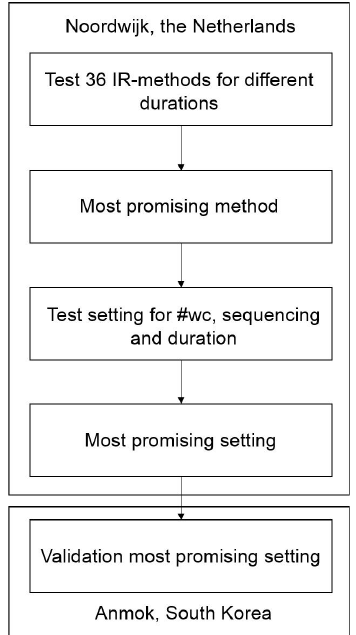
Figure 2. Flowchart of the research outline of this study, #wc is number of wave